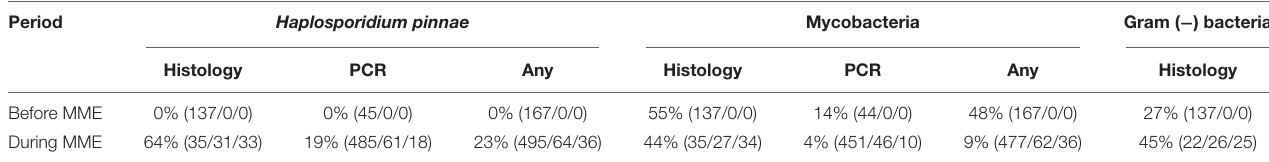
Period Haplosporidium pinnae Mycobacteria Gram ( − ) bacteria Histology PCR Any Histology PCR Any